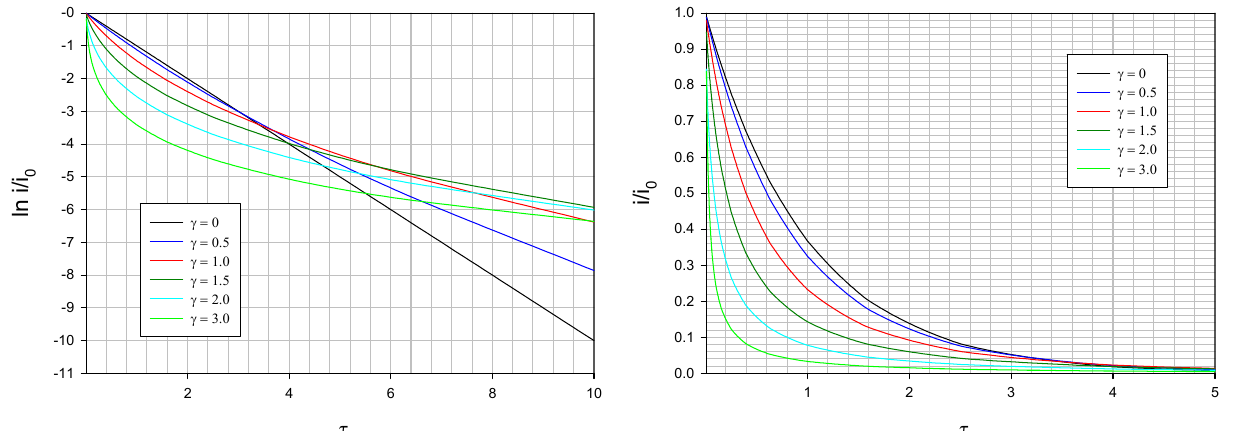
Figure 22. (a) Typical normalized current transients calculated for various values of the Gaussian spread parameter γ . (b) Semi-logarithmic representation of the data presented in fig.22(a), again as a function of spread